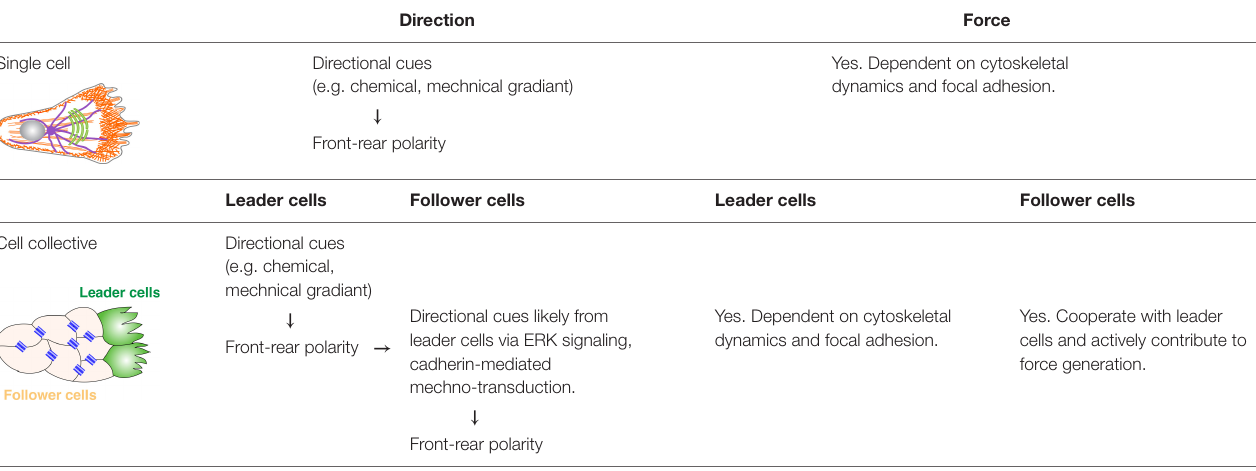
TABLE 1 | Comparison of direction determination and force generation between single cell migration and collective cell migration. Direction Force Single